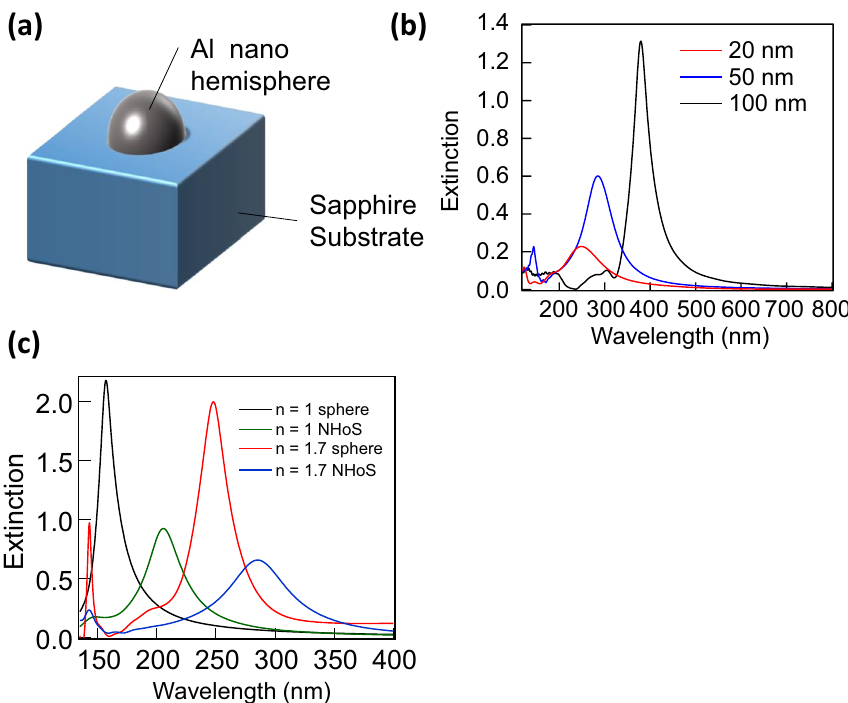
Figure 1. Extinction spectra of spherical and hemispherical Al nanostructures calculated by the FDTD method with various surrounding environment. ( a ) Schematic of Al nanohemisphere fabricated on sapphire substrate. ( b ) Calculated extinction spectra of Al nanohemisphere with diameters of 20, 50, and 100 nm. ( c ) Calculated extinction spectra of Al nanospheres with diameter of 50 nm in medium with refractive index of 1 or 1.7 and Al nanohemispheres with a diameter of 50 nm on substrate with refractive index of 1 or 1.7.